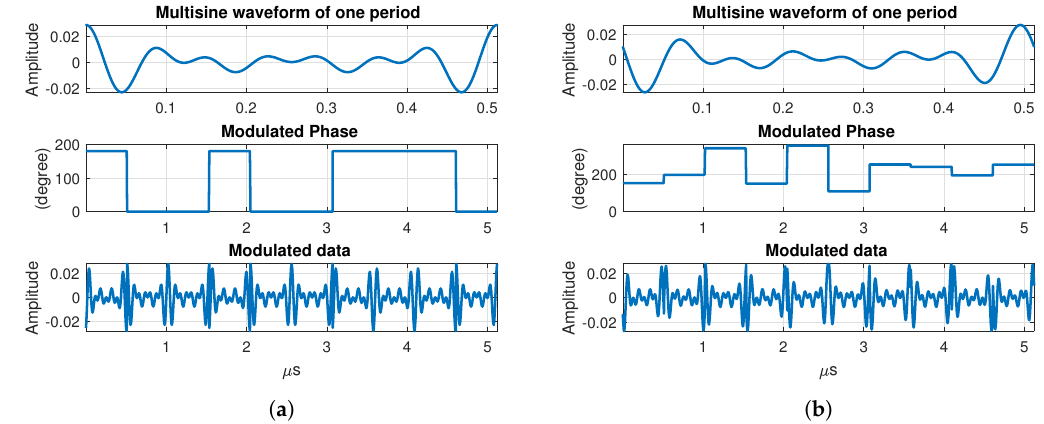
Figure 2. Four-tone multisine PSK modulation scheme ( a ) φ ( t ) ∈ { 0, π } and ( b ) φ ( t ) selected